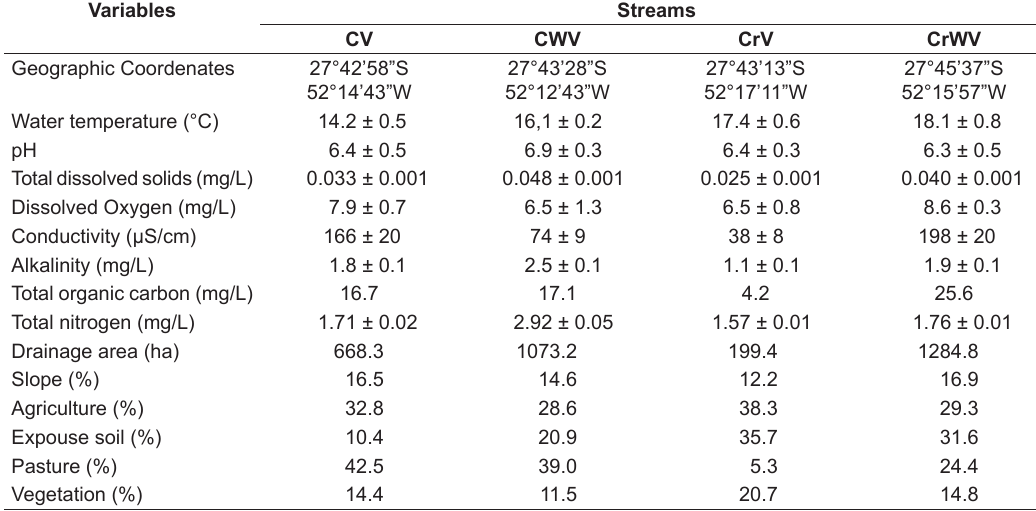
Table 1. Limnological variables (mean ± SD) and land uses (%) of the streams in the Campo river hydrographic sub-basin and Cravo river hydrographic sub-basin, Southern